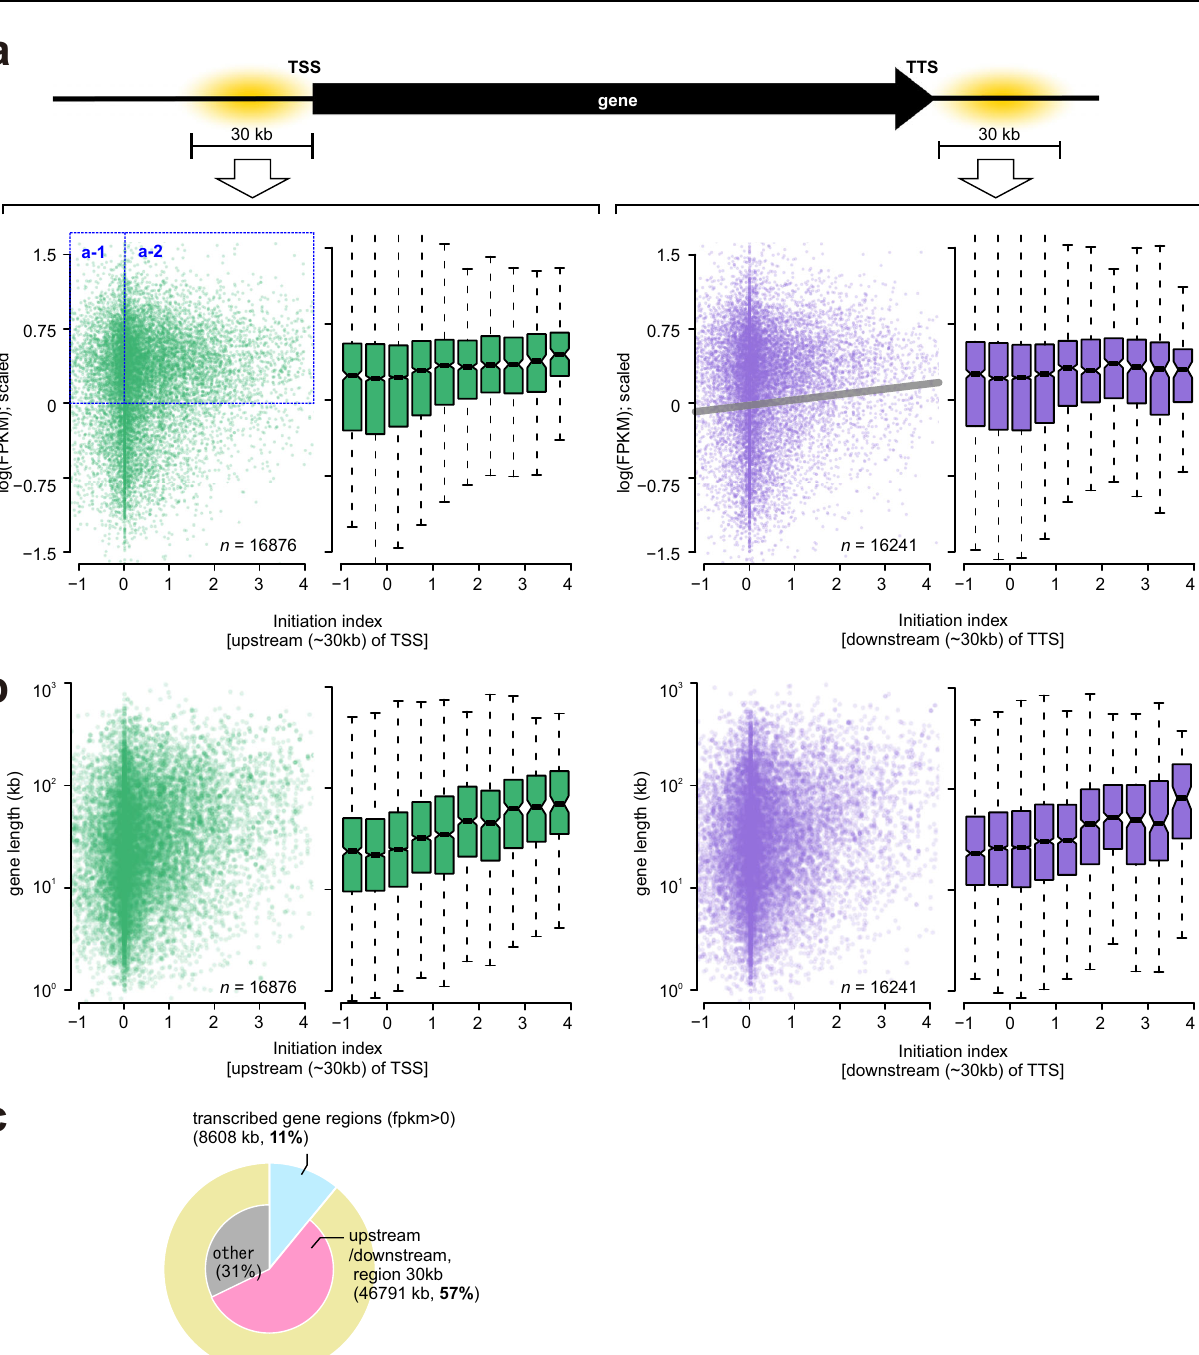
( n =16,876 of TSS and n=16,241 of TTS). c Summary diagram of initiation zones overlapped with genes or intergenic regions. Initiation zones were summed (total 81,587kb) and the ratio of total that overlapped with the following features were calculated; transcribed regions (FPKM>0, only protein-coding gene): light blue, non-transcribed: yellow, 0 – 30kbupstream/downstreamregion of genes: pink and ‘ other ’ , which includes intergenic regions and non-gene transcribed regions: grey. Only initiation zones that are concordant in all 3 replicates were analysed. For the boxplots in( a , b ),the horizontal black lines withinboxesrepresent medianvalues, boxes indicate the upper and lower quartiles (25 – 75%), and whiskers indicate the 1.5× interquartile